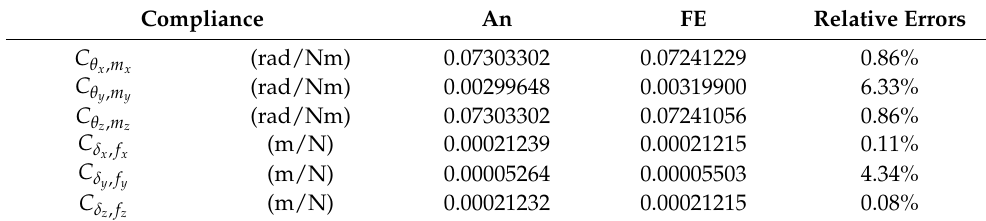
Table 3. The comparison of analytical results and the FE-results of compliance. Compliance An FE Relative